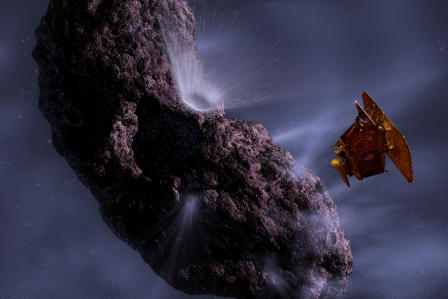
Artist's conception of the Deep Impact spacecraft observing the birth of the new crater on Tempel 1(Image: NASA/JPL/UMD; art: Pat Rawlings)